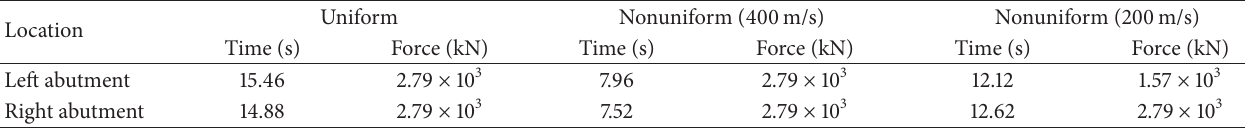
Table 2: Peak response of pounding force.